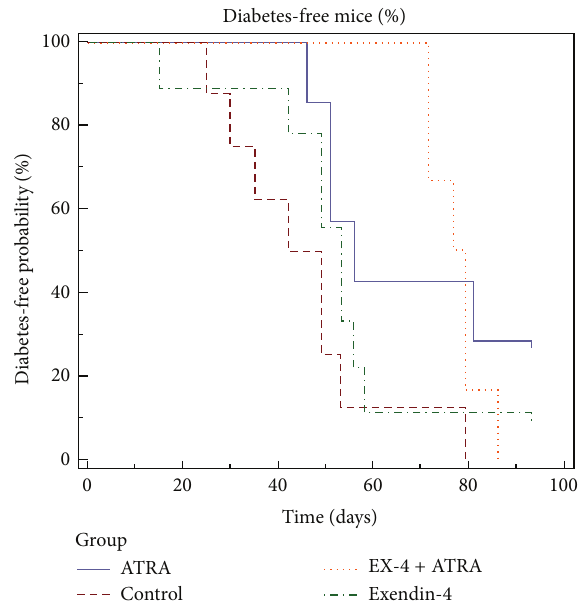
Figure 1: Kaplan-Meier curve of the percentage of diabetes-free mice over time in vehicle (brown line), ATRA- (blue line), exendin- 4- (EX-4, green line), and ATRA plus exendin-4- (orange line) treated groups. Adoptive-transfer was performed and treatment was started at day 0. Compared with vehicle, ATRA ( 𝑃 = 0.022 ) and ATRA plus exendin-4 ( 𝑃 = 0.013 ) treatment delayed the onset of diabetes.